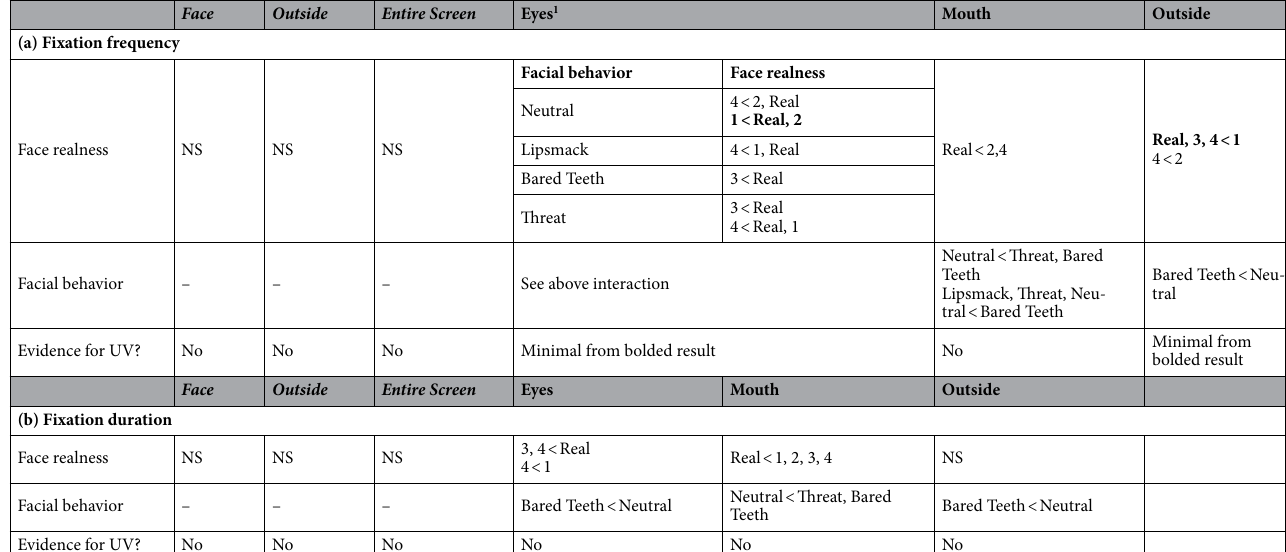
lipsmack or threat (lipsmack: Real vs Face 4: z = − 3.21, p = 0.012, Face 1 vs Face 4: z = − 2.92, p = 0.029, Fig. 2c; threat: Real vs Face 4: z = − 3.35, p = 0.007; Face 1 vs Face 4: z = − 2.89, p = 0.032; Fig. 2d), indicating reduced attention to less realistic eyes. This pattern of reduced attention toward less realistic eyes also held when look- ing at the duration of fixations directed toward the eyes. Subjects looked for longer at eyes in the Real image compared to either of the two least realistic faces (Faces 3 and 4) (Real vs Face 4: z = 4.31, p < 0.001; Real vs Face 3: z = 3.51, p = 0.004; Fig. 4a). Attention toward the mouth showed the opposite pattern as attention toward the eyes. Subjects fixated more times (Real vs Face 4: z = 4.25, p = < 0.001; Real vs Face 2: z = 3.16, p = 0.014; Fig. 5a) and for longer durations (Real vs Face 4: z = − 5.16, p < 0.001; Real vs Face 3: z = − 3.75, p = 0.002; Real vs Face 2: z = − 4.96, p < 0.001; Real vs Face 1: z = − 3.00, p = 0.023, Fig. 5c) on more manipulated mouths compared to mouths in Real images. Additionally, subjects attended to salient areas of interest depending on facial behavior as evidenced by greater attention to the mouths of face stimuli depicting facial behaviors that include exaggeration to this area (bared teeth, threat) (Fig. 5b, Fig. 5d, Table 1). Specifically, subjects looked at the mouth fewer times when the stimulus depicted a neutral facial behavior compared to any of the other facial behaviors (neutral vs bared teeth: z = 13.77, p < 0.001; neutral vs lipsmack: z = 9.30, p < 0.001; neutral vs threat: z = − 10.46, p < 0.001)